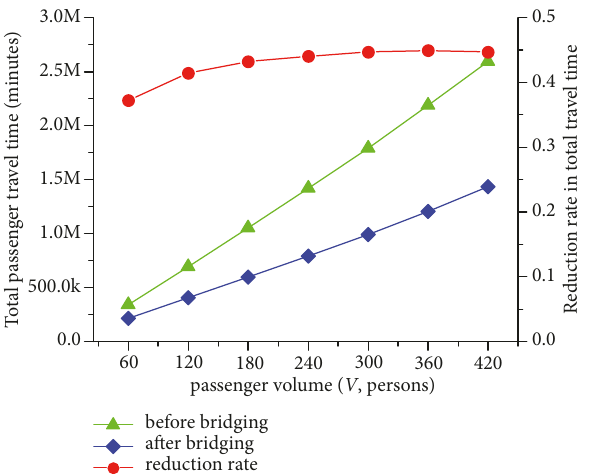
Figure 16: The optimization results under different passenger flow